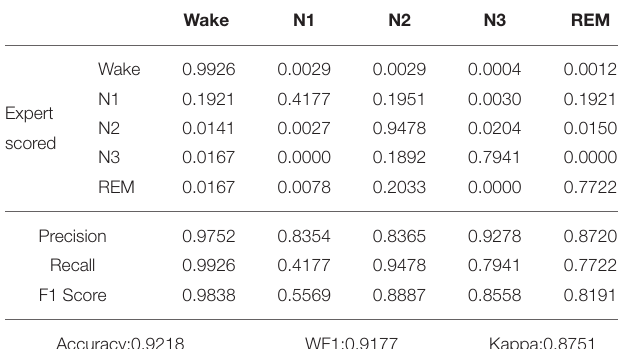
TABLE 2 | Confusion matrix and classification performance of proposed model applied on Sleep-EDF dataset.